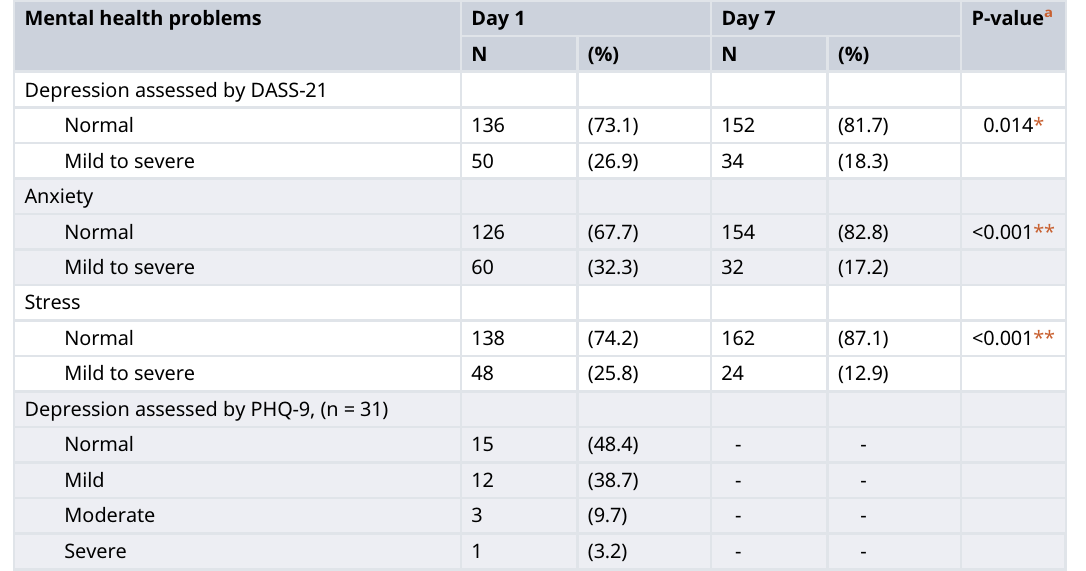
Table 3. Prevalence of mental health problems on day 1 and day 7 (N =